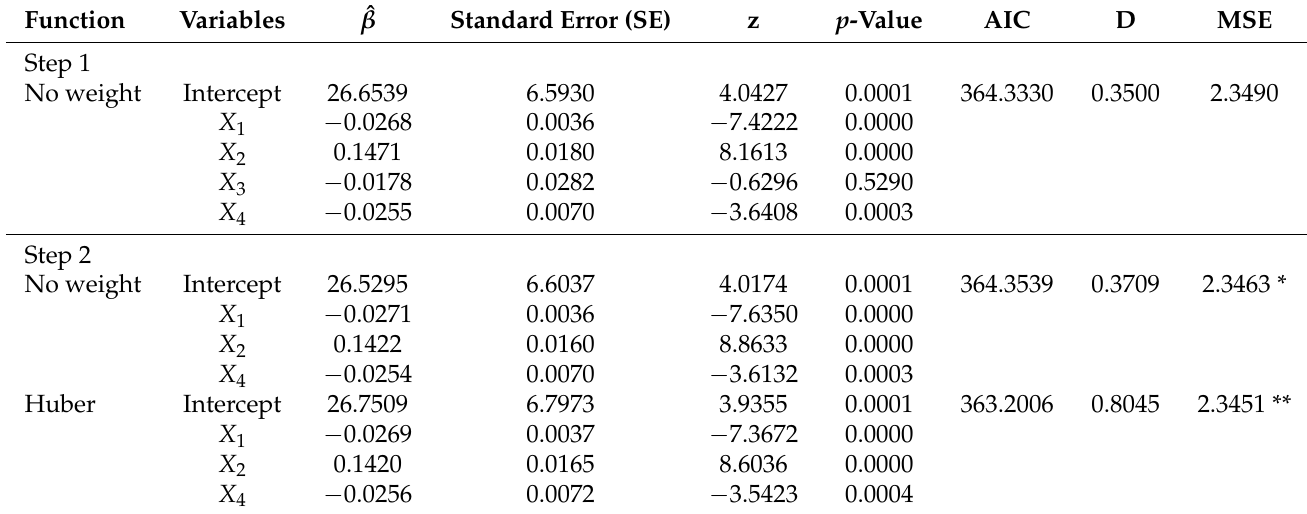
Table 2. Akaike’s information criterion (AIC), deviance (D), and mean squared error (MSE) of the Model VI (backward selection